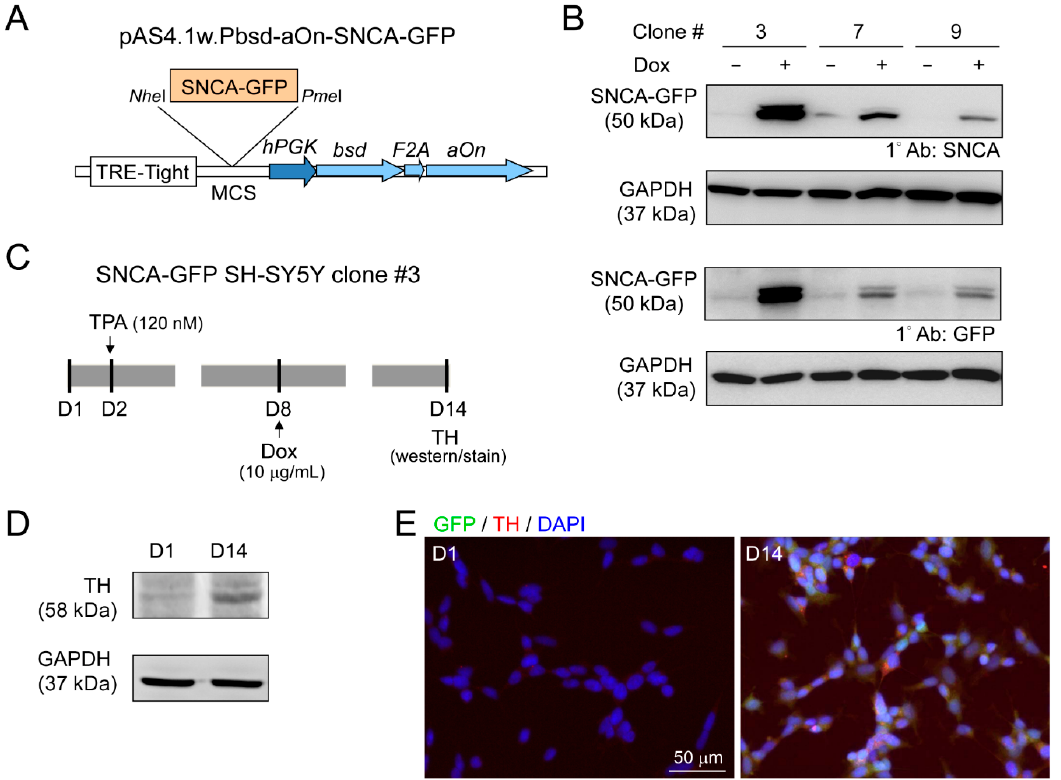
Figure 4. Human neuroblastoma SH-SY5Y cells with induced SNCA-GFP expression. ( A ) pAS4.1w.Pbsd-aOn-SNCA-GFP plasmid. The eukaryotic expression cassette was engineered to lentiviral vector with in-frame fused bsd (blasticidin, selective marker), F2A (protease, cleaving fusion protein into functional bsd and aOn), and aOn (transcription factor, activating TRE-Tight in the presence of doxycycline) under human phosphoglycerate kinase ( hPGK ) promoter. The SNCA-GFP gene was cloned between Nhe I and Pme I sites of multiple cloning site (MCS) and driven by TRE-Tight promoter which contains seven copies of modified tetO tetracycline repressor binding sequence. ( B ) Western blot images of GFP and α -synuclein in SNCA-GFP SH-SY5Y cell clones 3, 7, and 9 after induction for two days (+ Dox, 10 μ g/mL). GAPDH was used as a loading control. ( C ) Experimental flow chart. On day two, cells (SNCA-GFP SH-SY5Y clone 3) were incubated in medium containing TPA (120 nM) to promote DAergic differentiation of SH-SY5Y cells. On day eight, SNCA-GFP expression was induced with doxycycline (10 μ g/mL) for six days. On day 14, TH expression was examined. ( D ) Representative Western blot of TH on days one and 14 using GAPDH as a loading control. ( E ) Immunocytostaining of TH (red) on days one and 14 in SNCA-GFP-expressing SH-SY5Y cells (green). Nuclei were counterstained with DAPI (blue).